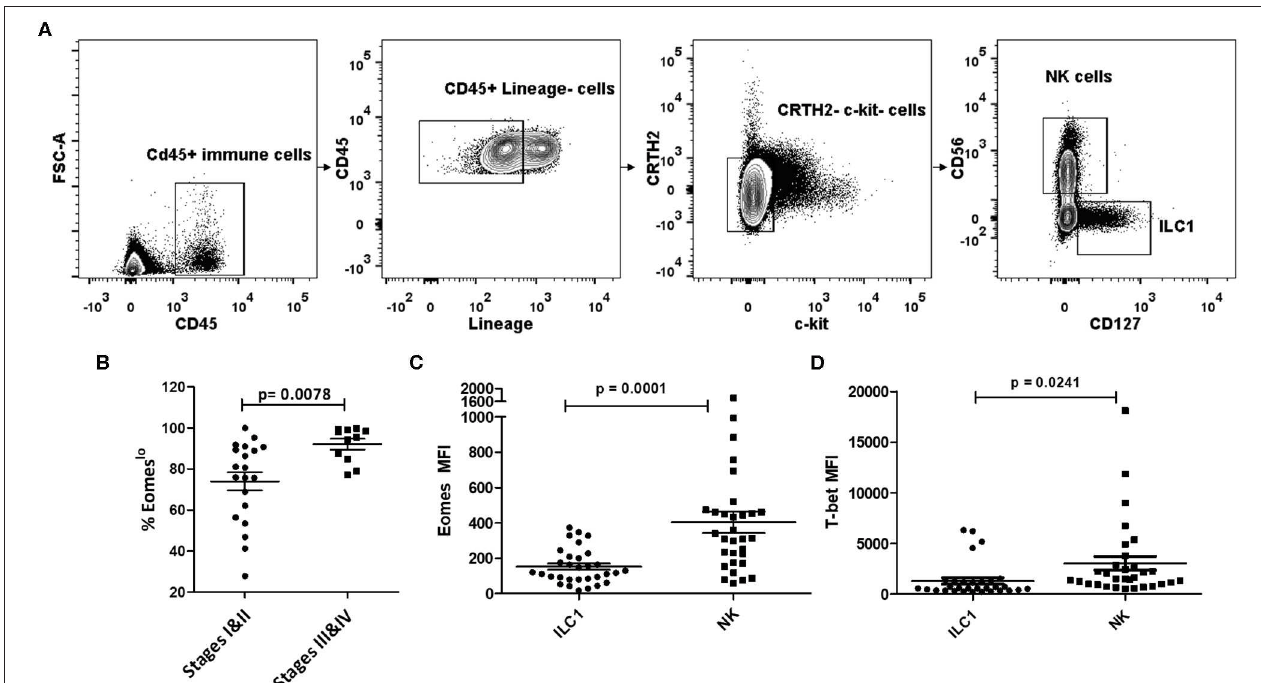
FIGURE 1 | Human Group 1 ILCs expressed Eomes differentially during NSCLC progression. (A) Gating for identification of Group 1 ILC subsets in peripheral blood of NSCLC patients. Group 1 ILCs were gated as CD45 + Lineage (CD3, CD19, CD11b, CD11c) − c-Kit − CRTH2 − ; ILC1s were further gated as CD127 + CD56 − and NK cells as CD127 − CD56 + (B) Percentage of Eomes lo subset gated over CD45 + Lineage (CD3, CD19, CD11b, CD11c) − c-Kit − CRTH2 − T-bet + cells at early stage (Stage I and II) vs. late stage (III and IV). Cancer progression is accompanied with increase in frequency of cells expressing lower Eomes levels (C) Quantification of Eomes expression in Group 1 ILC subsets, viz, ILC1, and NK cells. Peripheral blood NK cells showed higher Eomes levels compared to circulating ILC1s (D) Quantification of T-bet expression in Group 1 ILC subsets, viz, ILC1, and NK cells. Peripheral blood NK cells showed higher T-bet levels compared to circulating ILC1s. MFI is Mean Fluorescence Intensity, n = 16 for stage I, n = 4 for stage II, n = 4 for stage III, n = 7 for stage IV. Data are presented as mean ± s.e.m.; significance was tested using unpaired two tailed students’ t